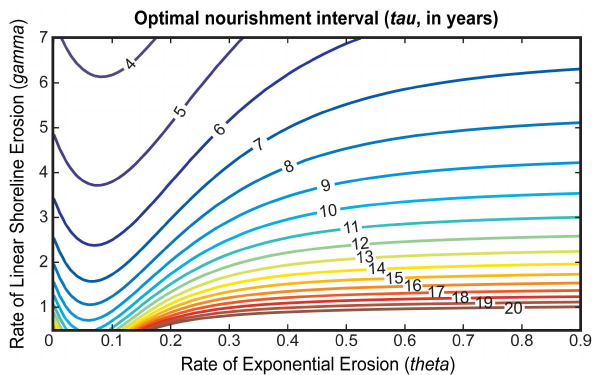
Fig. 1. Parameter space of optimal nourishment interval ( τ ) plotted as a function of linear erosion rate ( γ r ) and the exponential relax- ation rate of the cross-shore beach profile ( θ r )